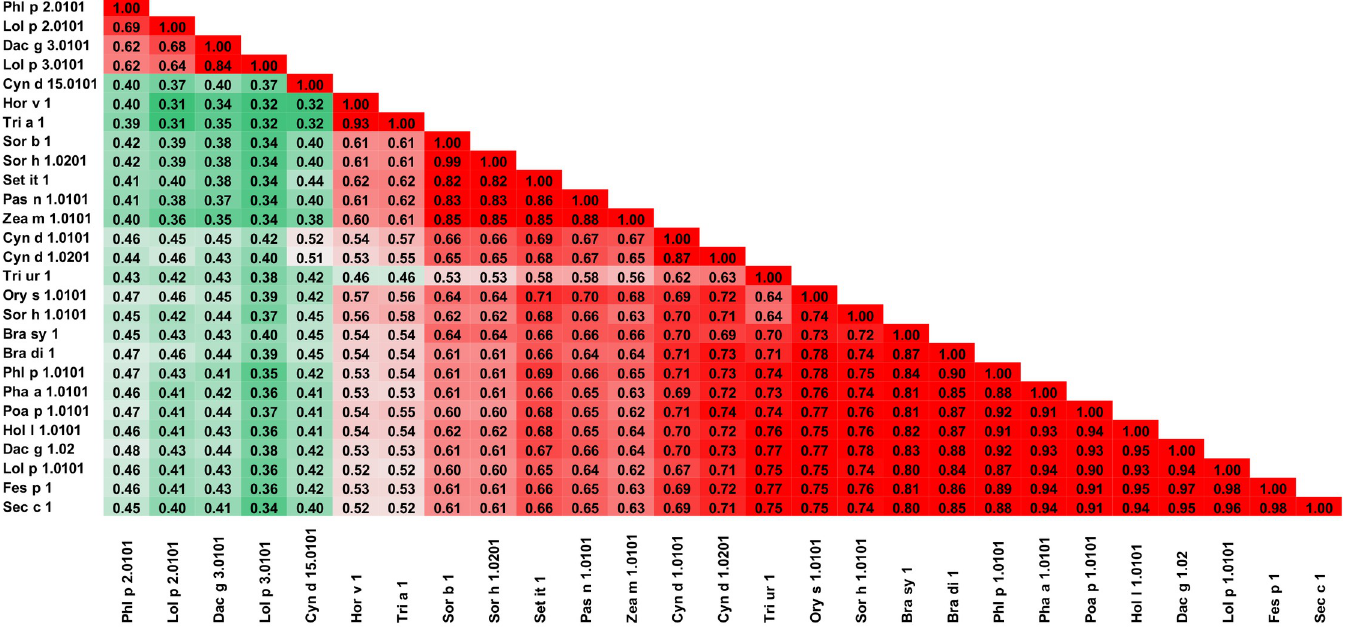
Fig 14. Plot showing A-RISC index values for allergen pairs from the β -expansin family and expansin-related proteins. Red color indicates a high risk of cross- reactivity, a dark green color indicates a low risk of cross-reactivity, and intermediate colors correspond to a medium risk of